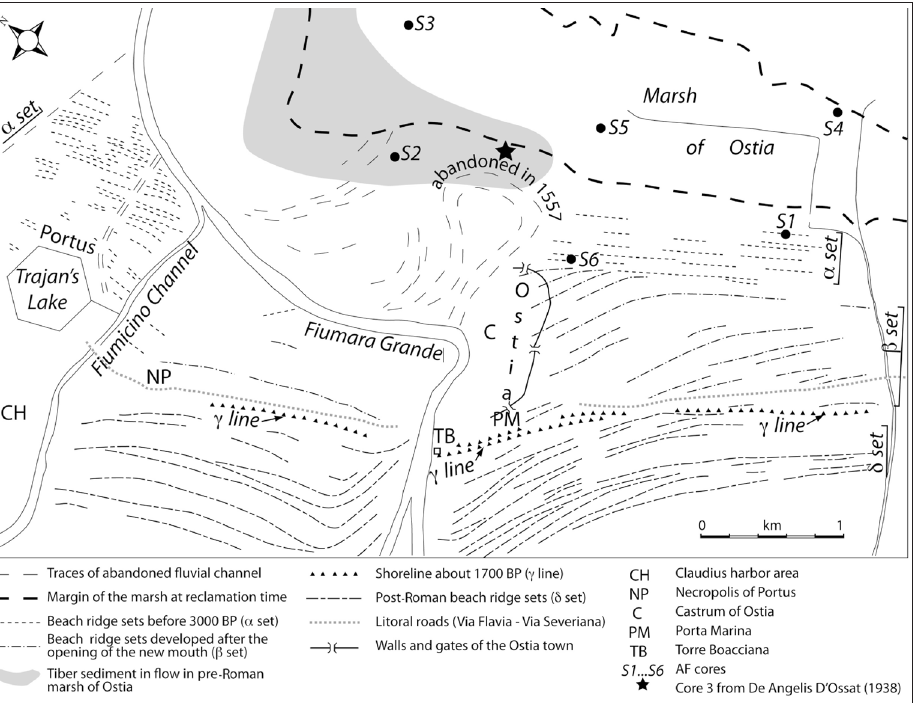
Figure 9: Morphological features of the Tiber river delta plain (Bellotti et al. 2011: fig.